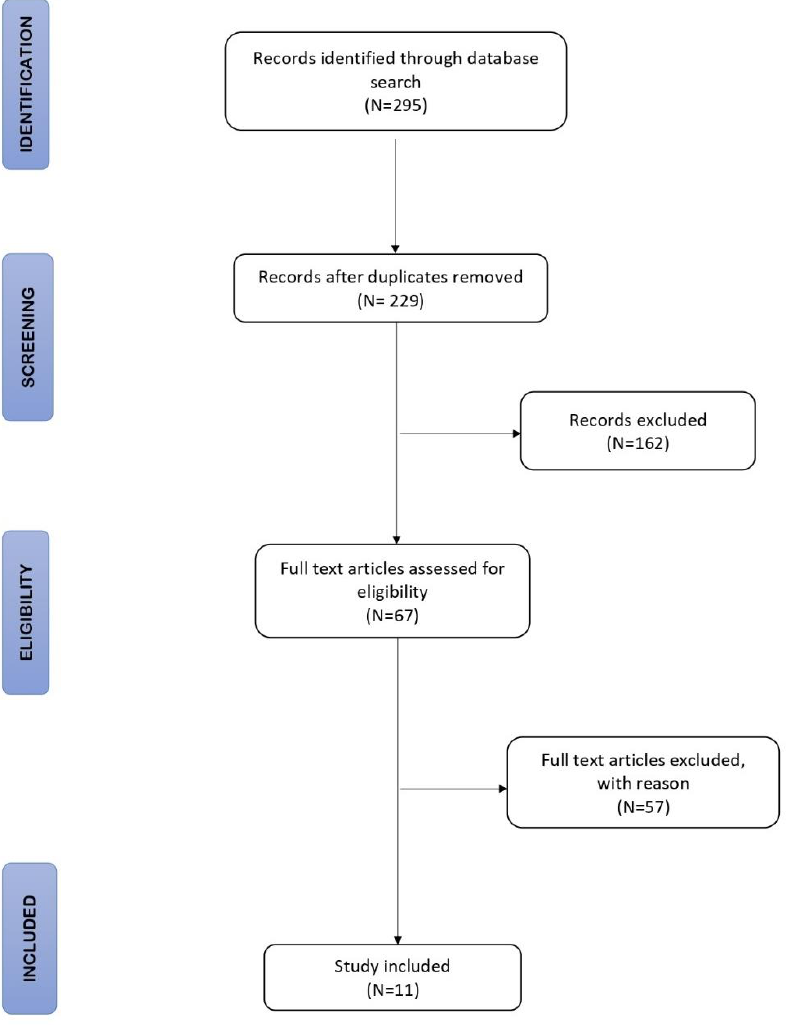
Figure 1. Preferred Reporting Items for Systematic review and Meta-Analysis (PRISMA) flow